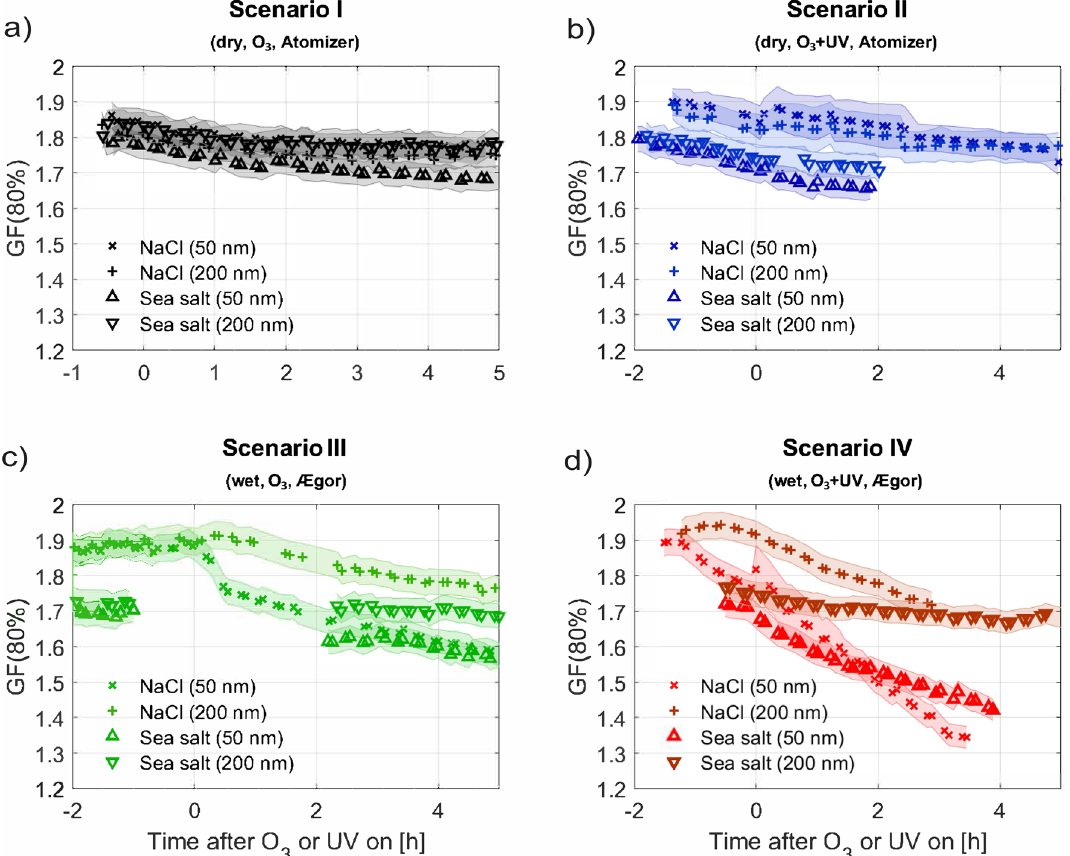
Figure 1. Effect of sea salt ageing on hygroscopicity. Growth factor (GF) measured at RH = 80% for NaCl and sea salt for dry particle sizes of D dry = 50 nm and 200 nm. ( a ) Scenarios I (dry particles, dry chamber, O 3 ); ( b ) Scenario II (dry particles, dry chamber, O 3 , UV); ( c ) Scenario III (humid conditions, O 3 ); ( d ) Scenario IV (humid conditions, O 3 , UV). The 0-time-point marks the exposure start time to O 3 or OH. During t < 0, no oxidant was present in scenario I and III, while particles together with O 3 were present in the scenarios II and IV. The uncertainties represent the combined uncertainties of the GF(80%) measurement itself and the standard deviations from averaging the different experiments.